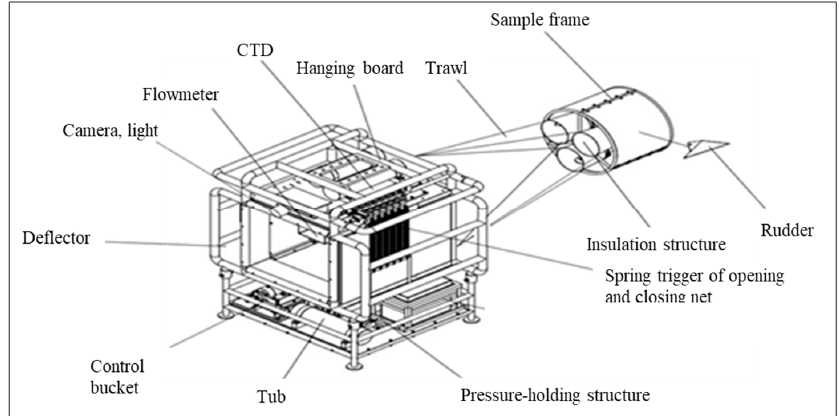
Figure 1. The overall structure of the multi-link visual control large-caliber trawl system.